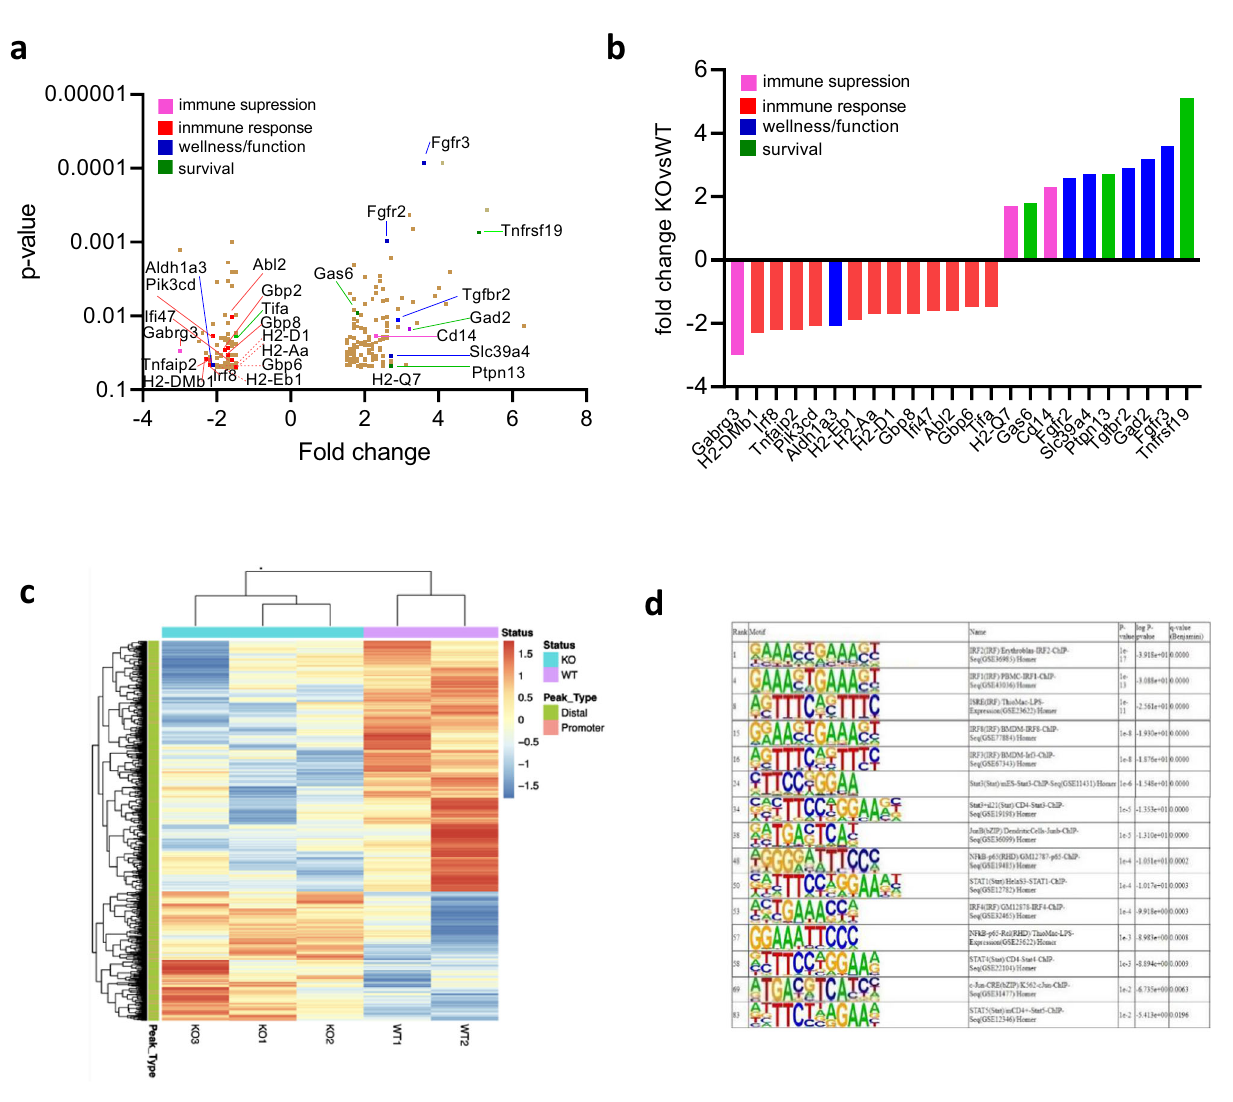
Fig. 5 β cells lacking Tet2 have reduced in fl ammatory responses. a Volcano plot showing gene expression differences in β cells from KO vs WT recipients of WT bone marrow. Eight weeks after the bone marrow transfer, β cells that are TMRE + Zinc + were sorted from KO vs WT recipients and subjected to the cDNA library preparation and bulk RNA-seq analysis. There are 333 differentially expressed genes in total with p < 0.05 after FDR correction, and 199 with fold change >1.5 that are shown in a . Genes of particular interest are color-coded in a and b according to their function. c Comparison of ATAC-seq pro fi les identify chromatin accessibility changes in β cells from KO vs WT recipients of WT bone marrow. Of 60,449 accessible sites identi fi ed across the fi ve samples, 715 (~1%) had increased accessibility (FC >1.5) and 1387 (~2%) had reduced accessibility in (FC < − 1.5) in KO ’ s, respectively. d HOMER motif analysis identi fi ed 97 TF motifs enriched in peaks with decreased accessibility (closing peaks) in KO β cell samples ( q value <0.05), 15 of which are in fl ammatory mediators. The rank of the 97 TF motifs was sorted by q value. Data were from three sortings and three – four mice per group per